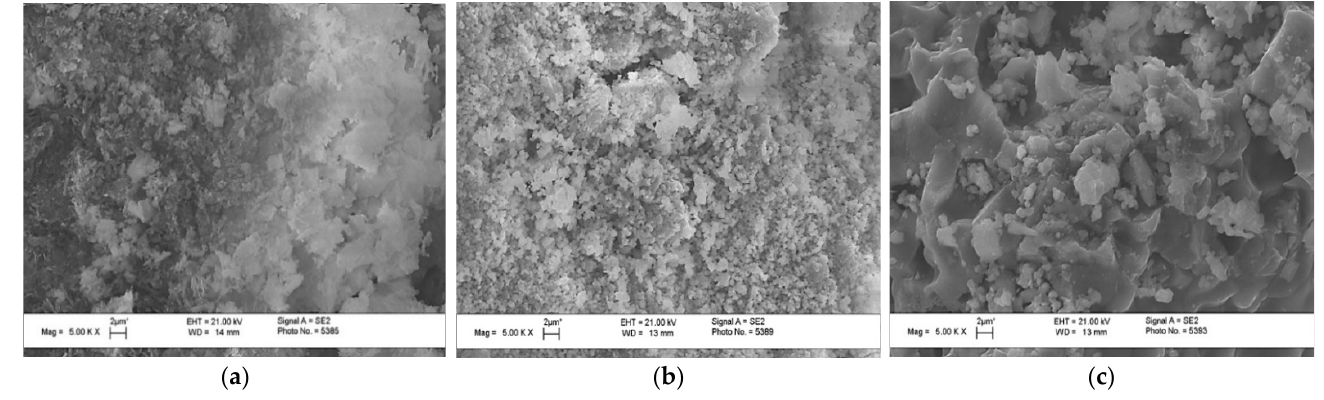
Figure 8. The SEM images of ceramic samples based on cement-salt stone prepared from powder mixture of calcium citrate tetrahydrate and sodium dihydrogen phosphate, after firing at temperatures of 500 °C ( a ), 700 °C ( b ), and 900 °C ( c ).